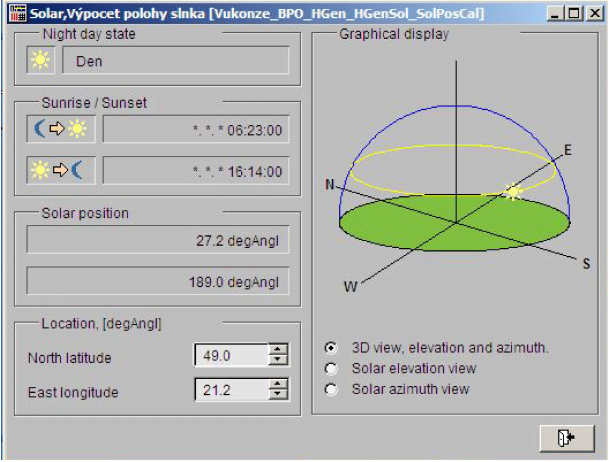
Figure 5. Setting the parameters in the Sun position calculation